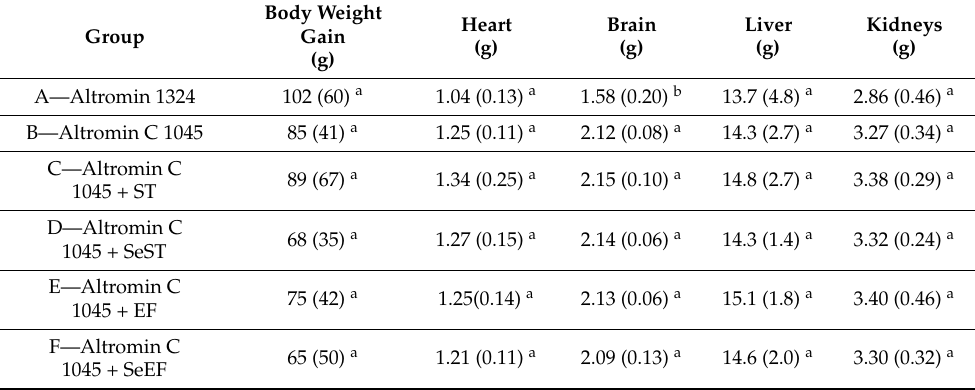
Table 3. The body weights and weights of organs in grams ( n = 8). Data are presented as the mean (standard deviation). a,b –values in columns with different supercase letters significantly differ ( p < 0.05).